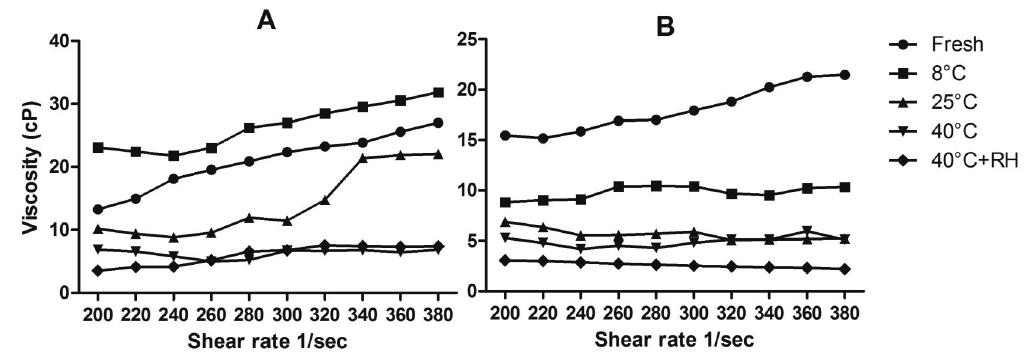
FIGURE 2 - Viscosities of MeA and MeB samples kept in different conditions, showing “dilatant” behavior. A = MeB viscosities; B = MeA viscosities.